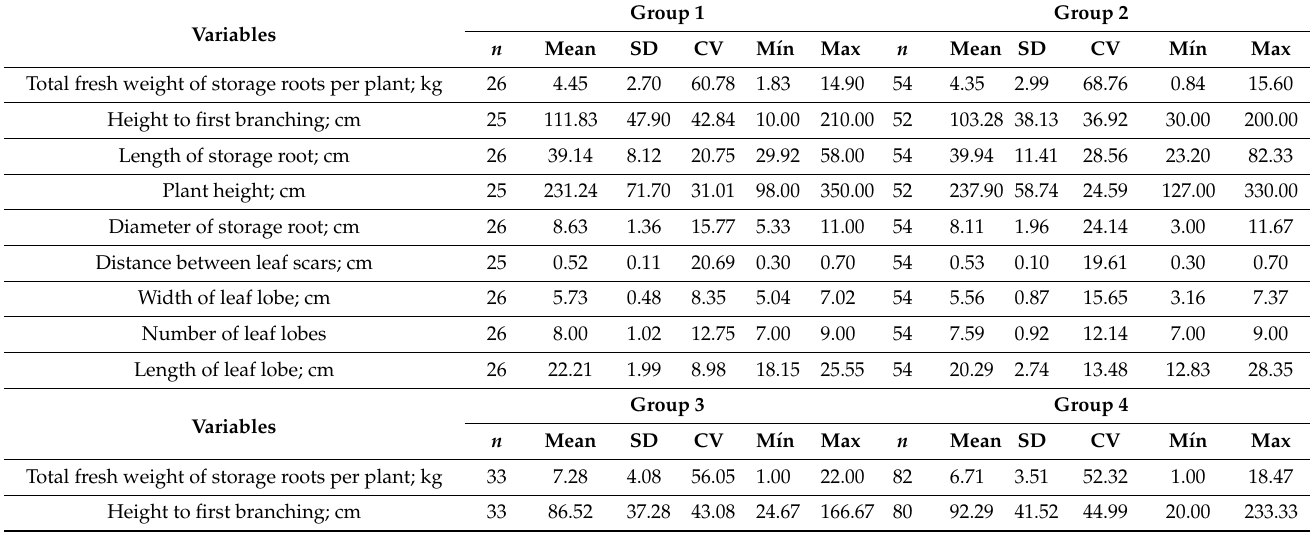
Table A2. Morphological variability of quantitative characters based on the three groups obtained through multivariate analysis of the Ecuadorian cassava